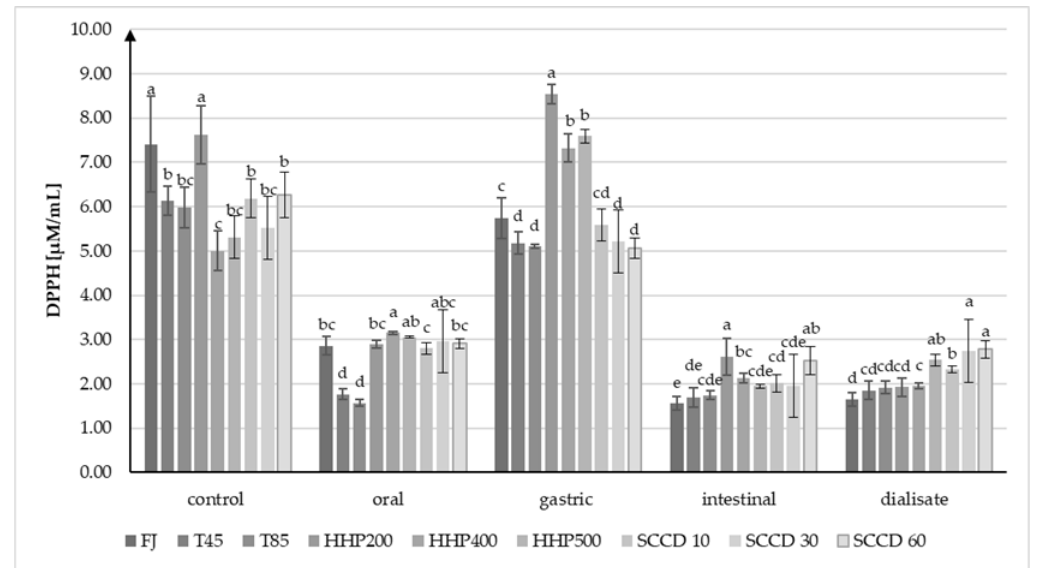
Figure 4. Results of DPPH • analysis of antioxidant properties (AC) of beetroot juice after different treatments on every stage of simulated digestion. FJ — untreated juice; T45 — thermal treatment of